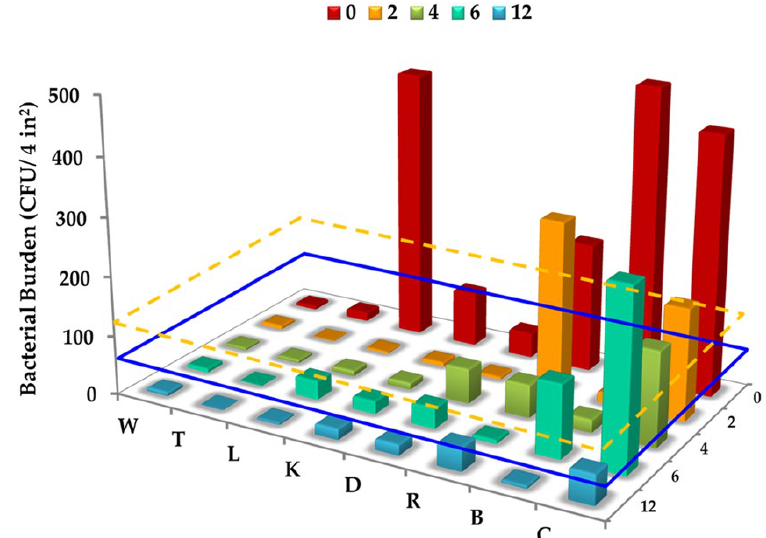
Figure 17. Bacterial load on wall (W), thermostat (T),locker (L), knob (K), soap dispenser (D), bathroom rail (R), bed rail (B), and kitchen counter (C) coated with polyhydroxy fullerenes containing anatase; initial concentration, and 2, 4, 6 and 12months after coating. Also counts of harmless level (blue line) and counts of bacteria on an average clinical copper surface (yellow dotted line) are shown. (Reprinted/adapted with permission from Ref.